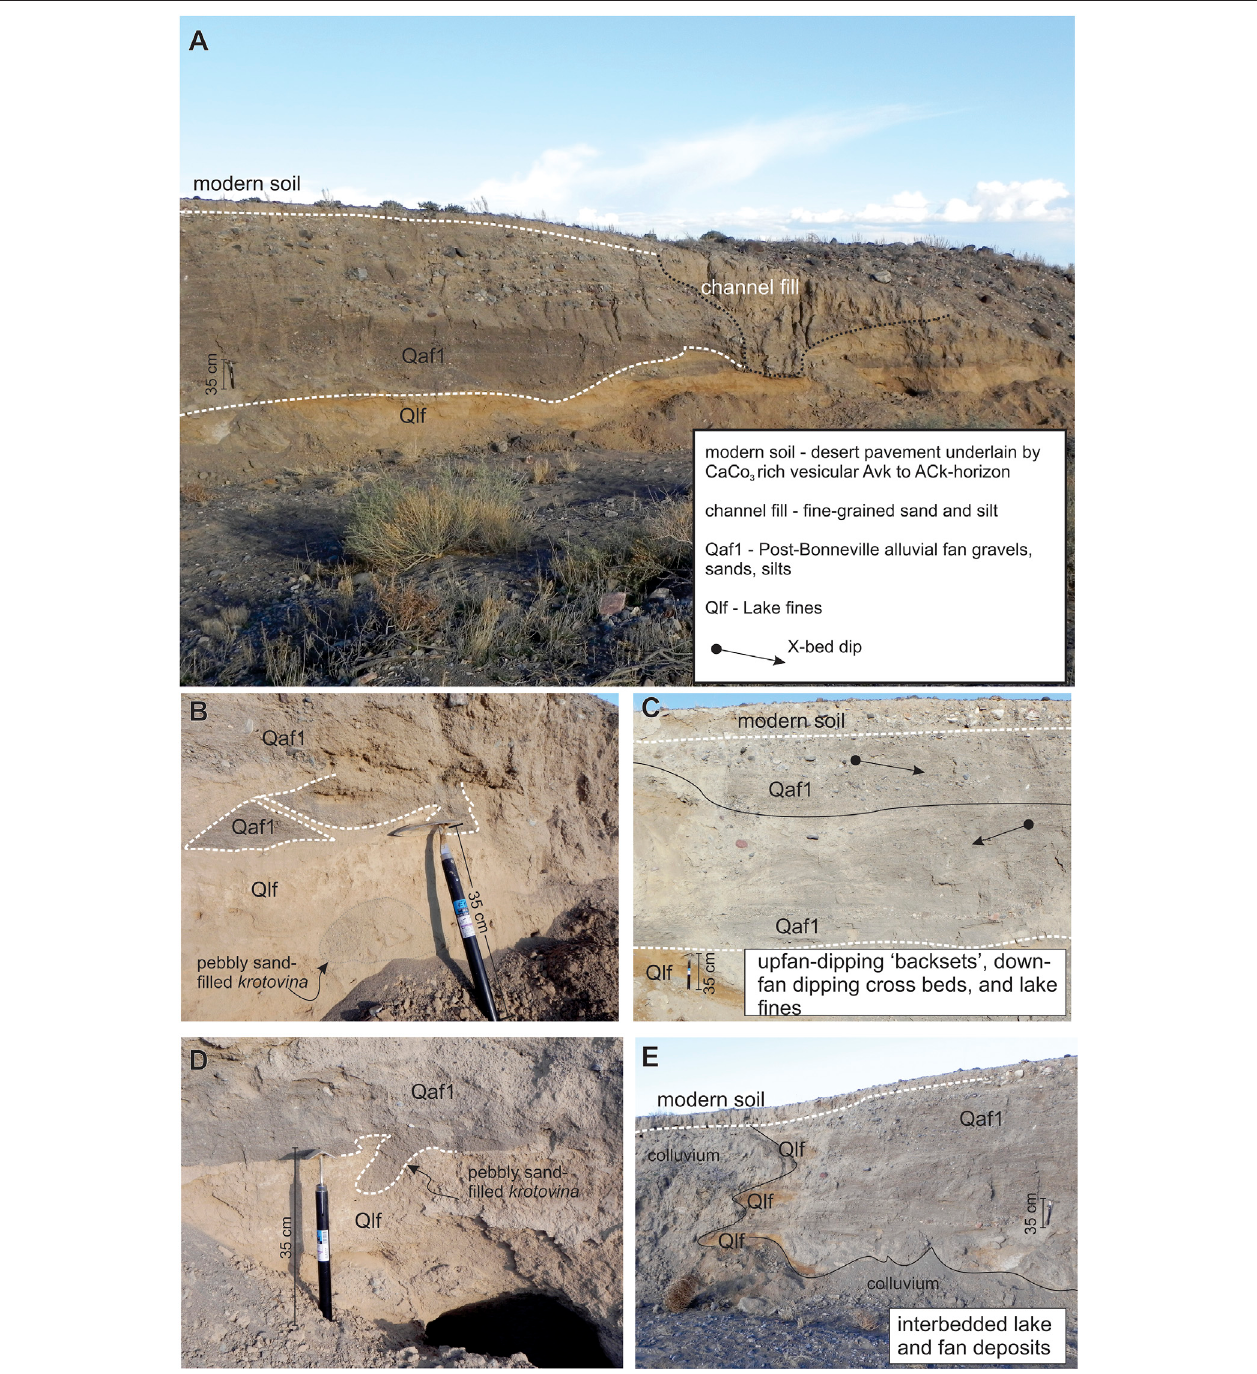
FIGURE 9 | Outcrop showing the contact of post-Bonneville alluvial fan (Qaf1) over Provo shoreline – aged lake fi nes (Qlf) near the elevation of the Provo shoreline (1,460 m) and immediately down-fan of pro fi le A-A' in Figure 5 . The relationships in B-E demonstrate that Qaf1 began forming immediately following the fall of the Bonneville shoreline and, at this location, formed relatively rapidly during occupation of the Provo shoreline. In more active locations, post-Provo channels have been incised and fi lled within the Qaf1 surface (A) and Figure 3 ). (B) Lenses of Qaf1 sandy gravel are present within Qlf near the contact. (C) Cross-beds within Qaf1 indicate bidirectional fl ow (arrows; up-fan and down-fan). (D) Possible burrow at the basalcontact between Qaf1 and Qlf. (E) Interbeds ofQlf and Qaf1 approaching the modern surface.